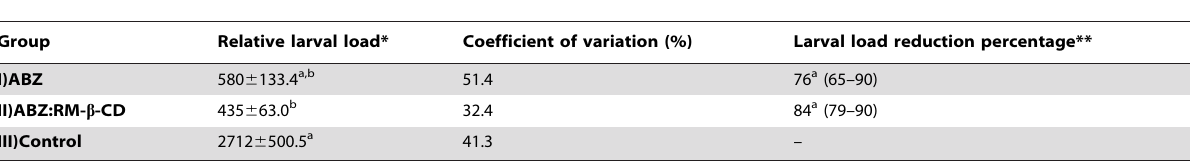
Table 1. Efficacy of the ABZ:RM- b -CD formulation on the muscle larval load of Trichinella spiralis infected CBi + males.